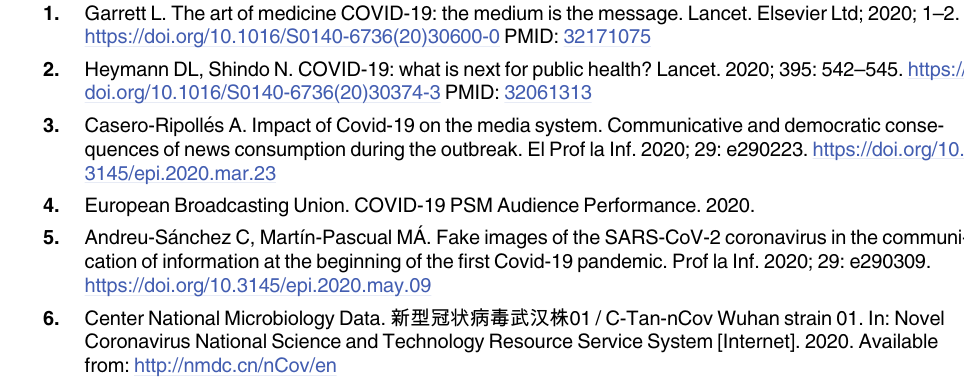
S2 Table. Analysis of the data based on the variable age. S3 Table. Analysis of the data based on the variable